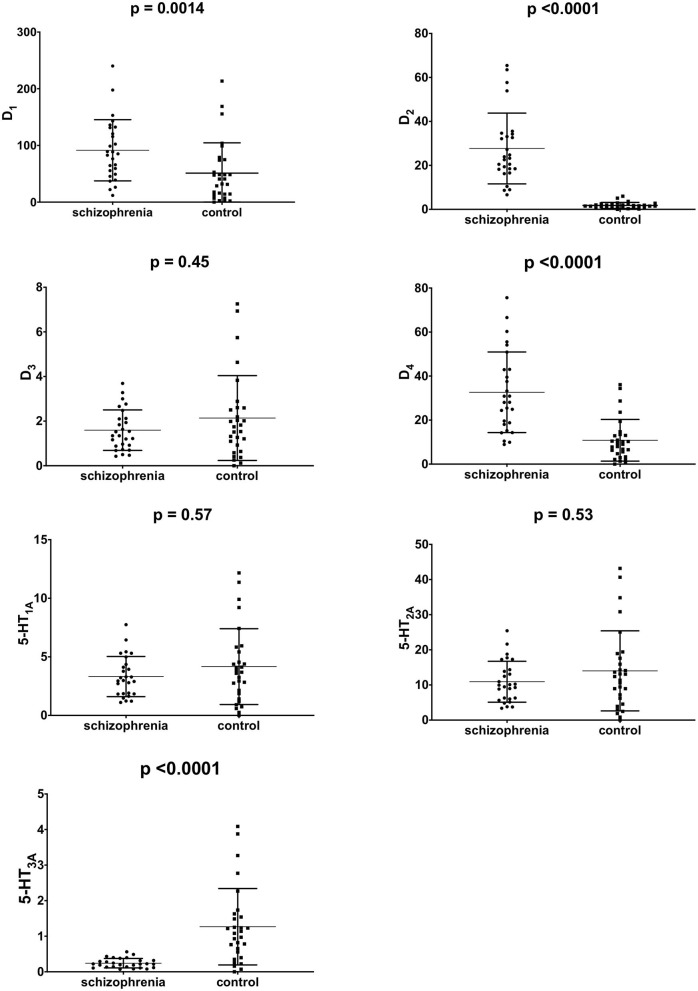
mRNA expression of dopamine D1−4 and serotonin 5-HT1A−3A in PBMCs of study subjects (unadjusted for smoking). Middle horizontal line indicate mean, outer horizontal bars represent standard deviation.